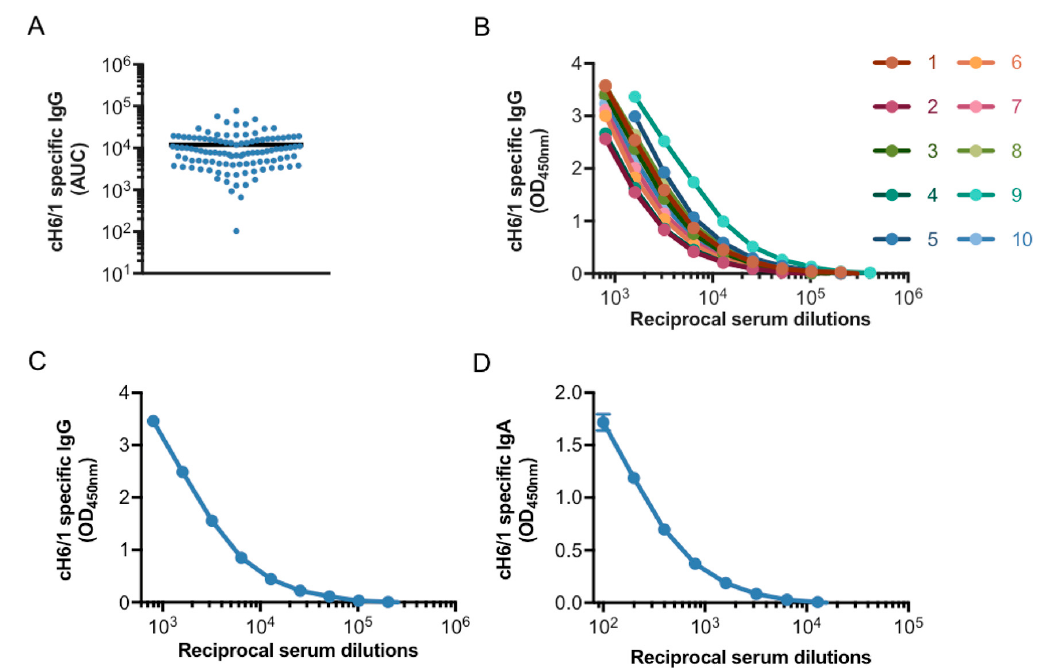
Figure 2. Testing and selection of human serum samples with high levels of stalk-specific antibodies. Samples of human sera were obtained from a commercial vendor ( n = 110) and screened for stalk-specific IgG antibodies using a cH6/1-based enzyme-linked immunosorbent assay (ELISA) ( A ). The 10 samples with the highest IgG titers were selected, and the full units were obtained. The full units were re-tested for cH6/1-specific IgG titers ( B ). A pooled serum (PS) consisting of equal amounts of serum from each of the 10 full units was generated. The PS exhibited high levels of stalk-specific IgG ( C ) and IgA ( D ) antibodies. Dots in A represent individual values of the Area Under the Curve (AUC) from every serum sample, the arithmetic mean of all values is represented by a black horizontal line. Specific Optical Density (OD) for each of the serum dilutions is shown in ( A – C ).